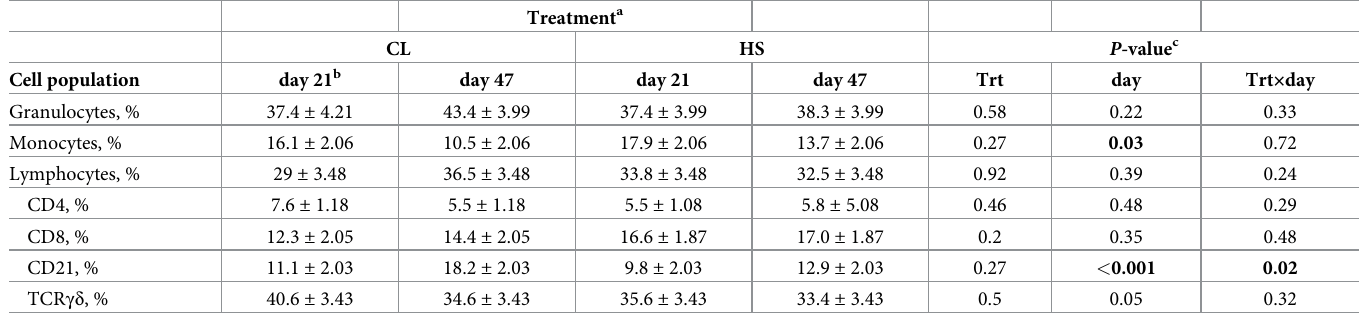
Table 3. Flow cytometric analysis of peripheral blood leukocytes of CL and HS calves at 21 and 47 d of